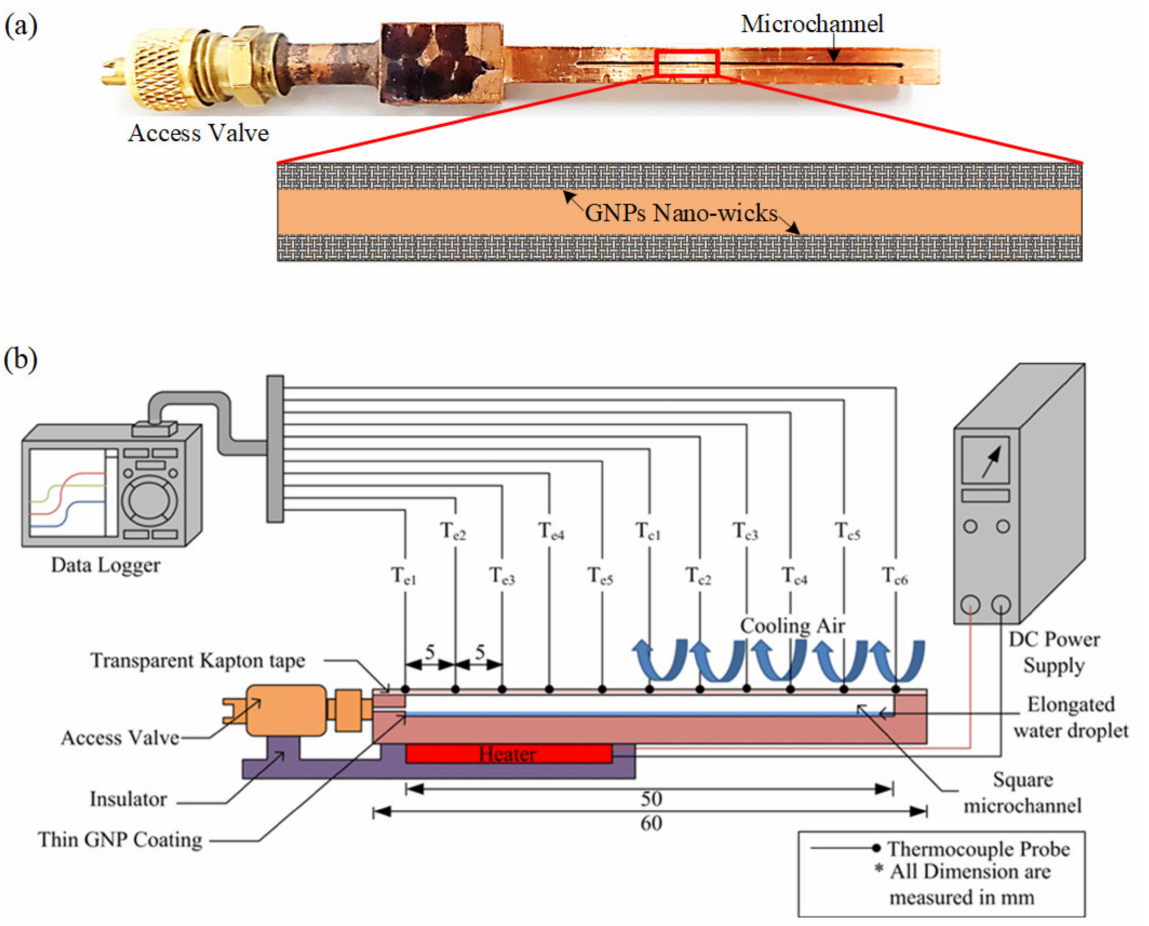
Figure 2. ( a ) Micro heat pipe with a microchannel grooved on a copper block. The GNP nano-wicks are constructed on the inner walls of the microchannel. ( b ) Schematic diagram of experimental setup for thermal performance evaluation of the micro heat